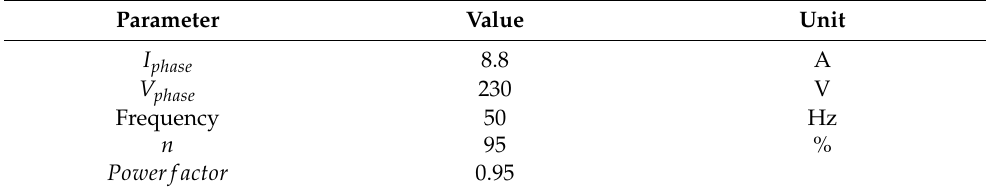
Table 1. Six kVA three-phase rotary transformer design and loading requirements. Parameter Value